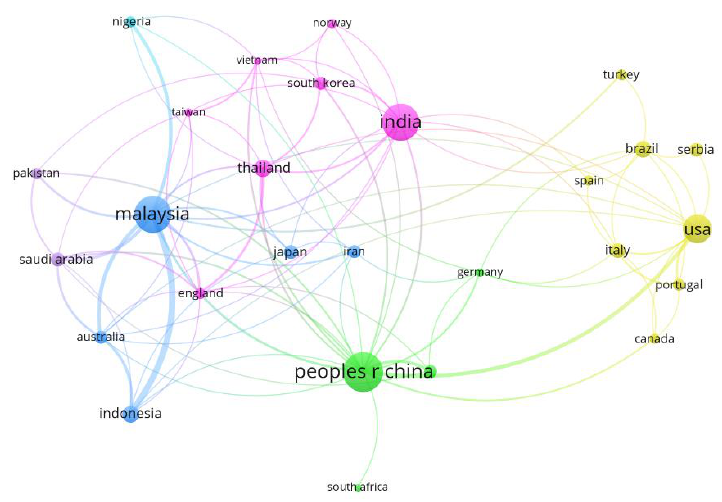
Figure 4. Network visualization map showing the collaboration among countries with at least five published papers. The thickness of the lines connecting two countries indicates the accumulation of co-authorships (thicker lines means more published articles), and the color clusters illustrate the groups of countries with a high level of collaboration.